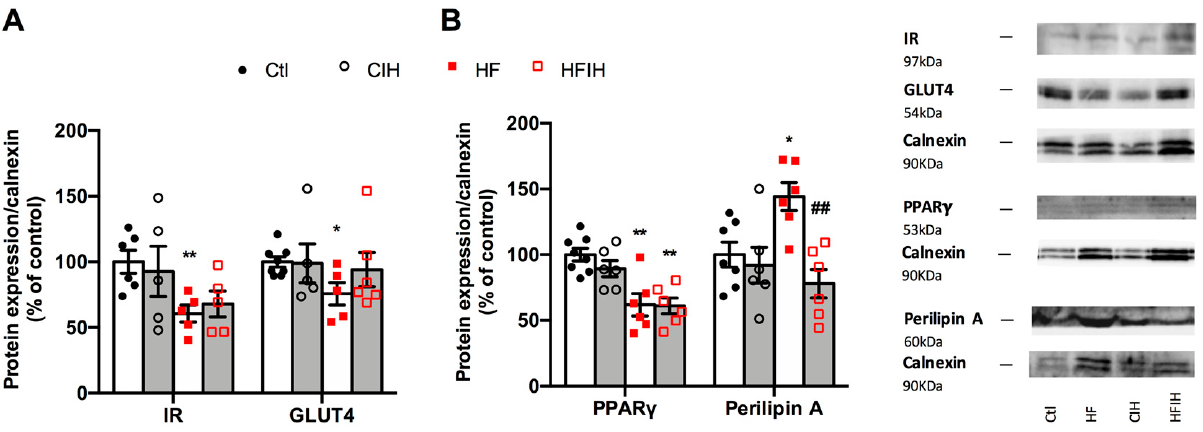
Figure 7. Effect of severe chronic intermittent hypoxia (CIH/IH) exposure on the metabolism of the adipose tissue. ( A ) Effect of severe chronic intermittent hypoxia (CIH/IH) exposure on adipose tissue (97 kDa) and glucose transporter GLUT4 (54 kDa) immunoreactivity in control and HF animals in relation to the expression of the loading protein, calnexin. ( B ) Effect of severe CIH on peroxisome proliferator-activated receptor γ (PPAR γ ) (53 kDa) and perilipin A (60 kDa) immunoreactivity in control and HF animals in relation to the expression of the loading protein, calnexin (90 kDa). Representative Western blots for each protein studied are depicted in the right panel. Data are presented as means ± SEM of 5–8 animals. One- and two-way ANOVA with Dunnett’s and Bonferroni multiple comparison tests, respectively: * p < 0.05 and ** p < 0.01, compared with control animals; ## p < 0.05 compared values with HF animals without CIH.